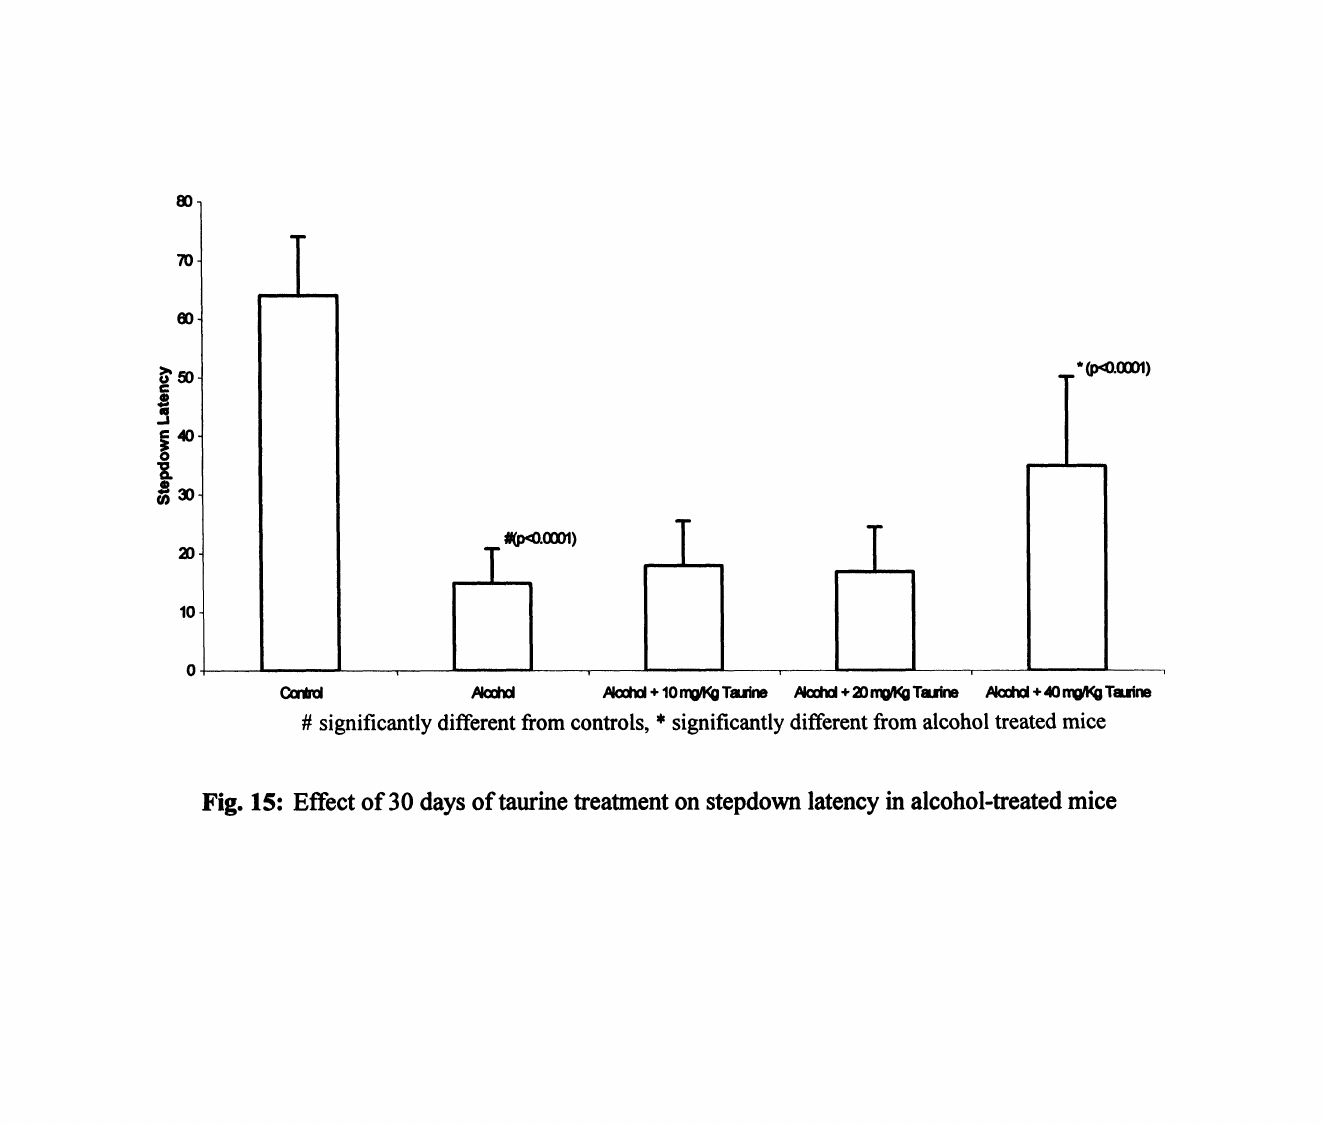
Fig. 14: Effect of 10 days oftaurine treatment on escape latency in alcohol-treated mice